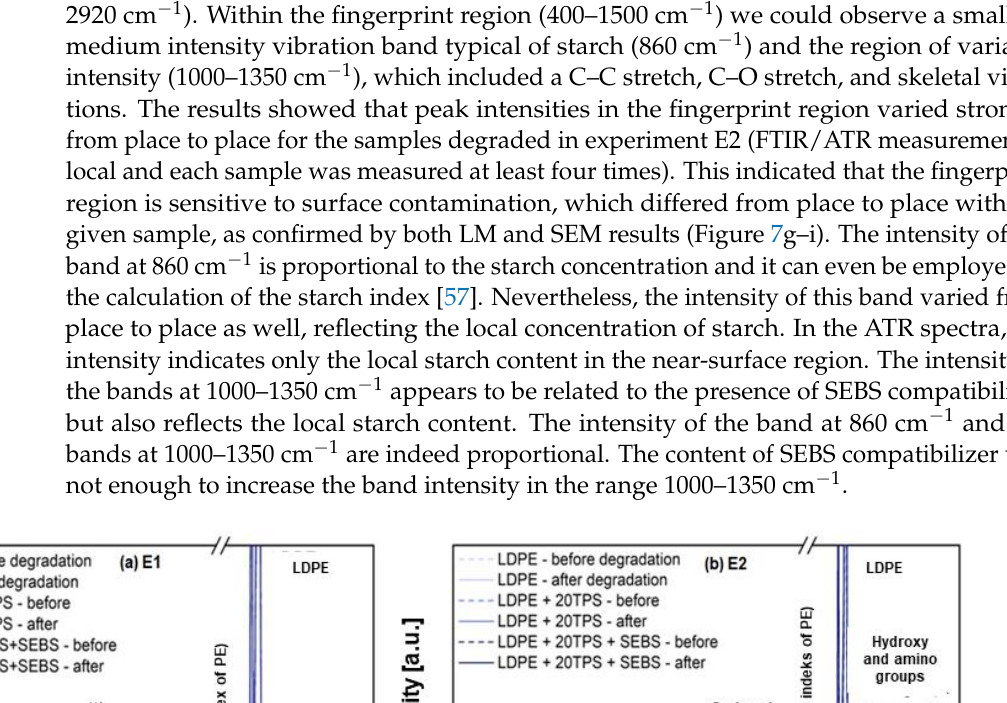
Figure 8. SEM micrographs showing fracture surface of LDPE, LDPE+20 TPS, and LDPE+20 TPS+SEBS before ( a – c ) and after degradation in experiments E1 ( d – f ) and in experiments E2 ( g – i ).